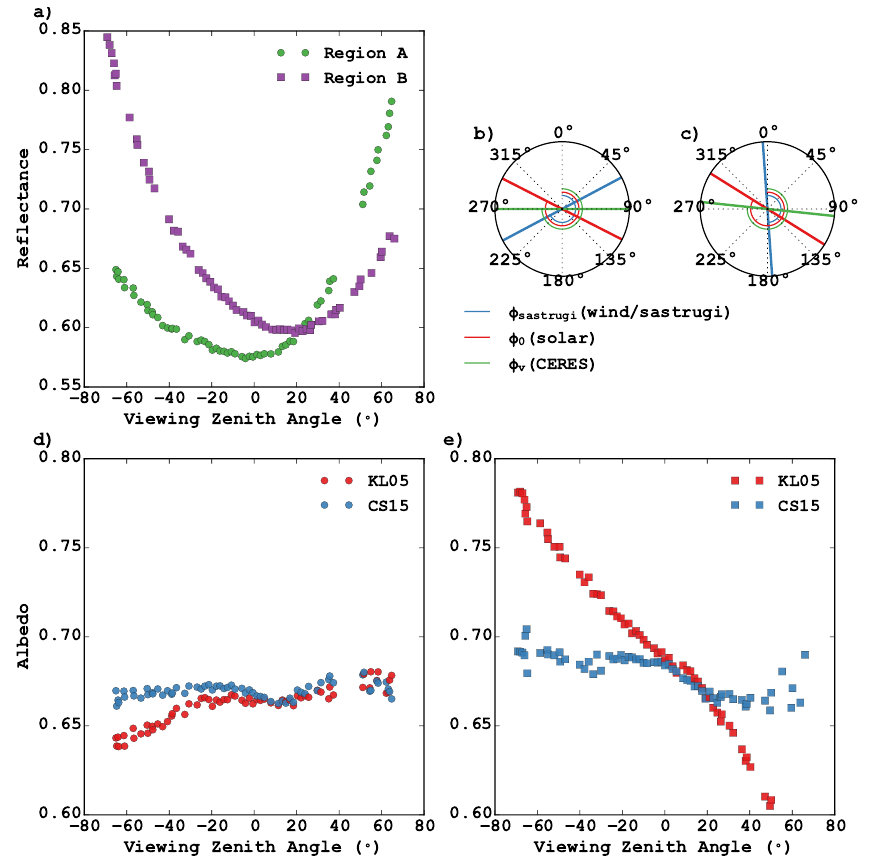
Figure 8. (a) Instantaneous clear-sky CERES reflectance values against viewing angle for two 1 ◦ × 1 ◦ grid boxes: 81 ◦ S, 163 ◦ W (green circles, 28/12/2004) and 81 ◦ S, 35 ◦ E (purple squares, 16/12/2003). (b) and (c) viewing and sastrugi azimuth (from the north) for the two grid boxes in (a) when the measurements were made; viewing azimuth (green line), φ sastrugi (blue), and φ v (red line). (d) Albedo against viewing zenith angle for the grid box 81 ◦ S, 163 ◦ W calculated using KL05 ADMs (red) and CS15 ADMs (blue). (e) as in (c) but for the grid box 81 ◦ S, 35 ◦